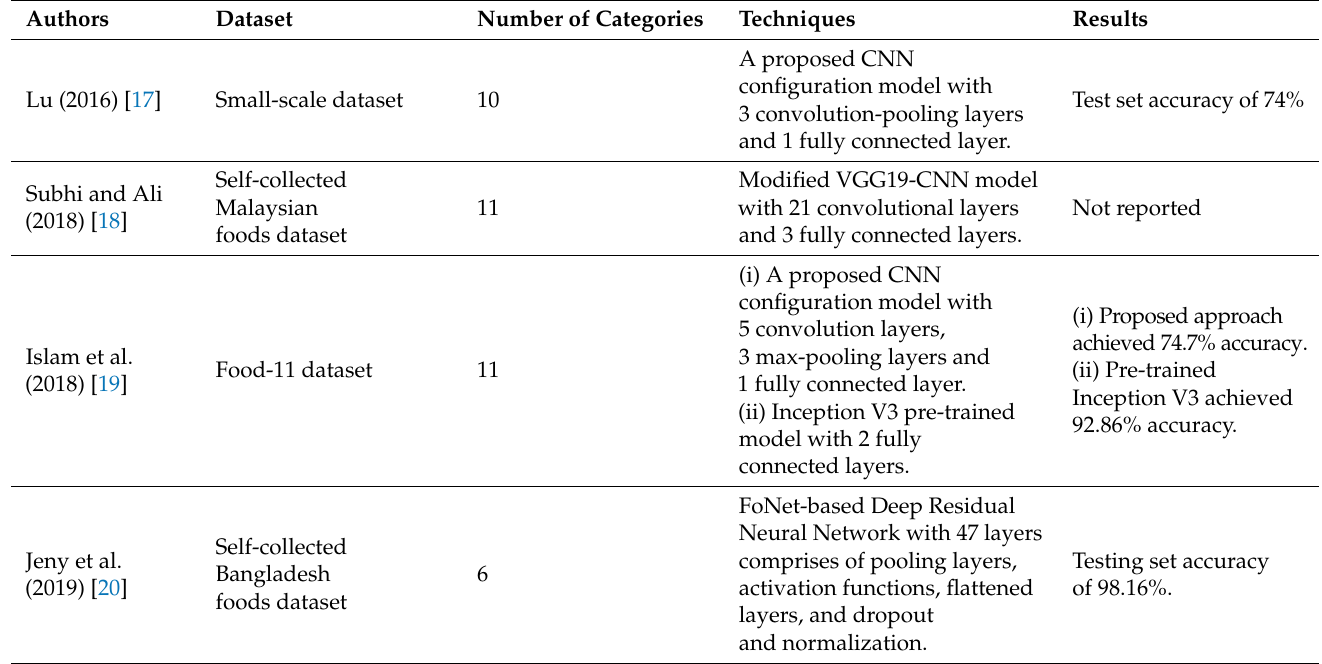
Table 1. A summary of related works on CNN models for food